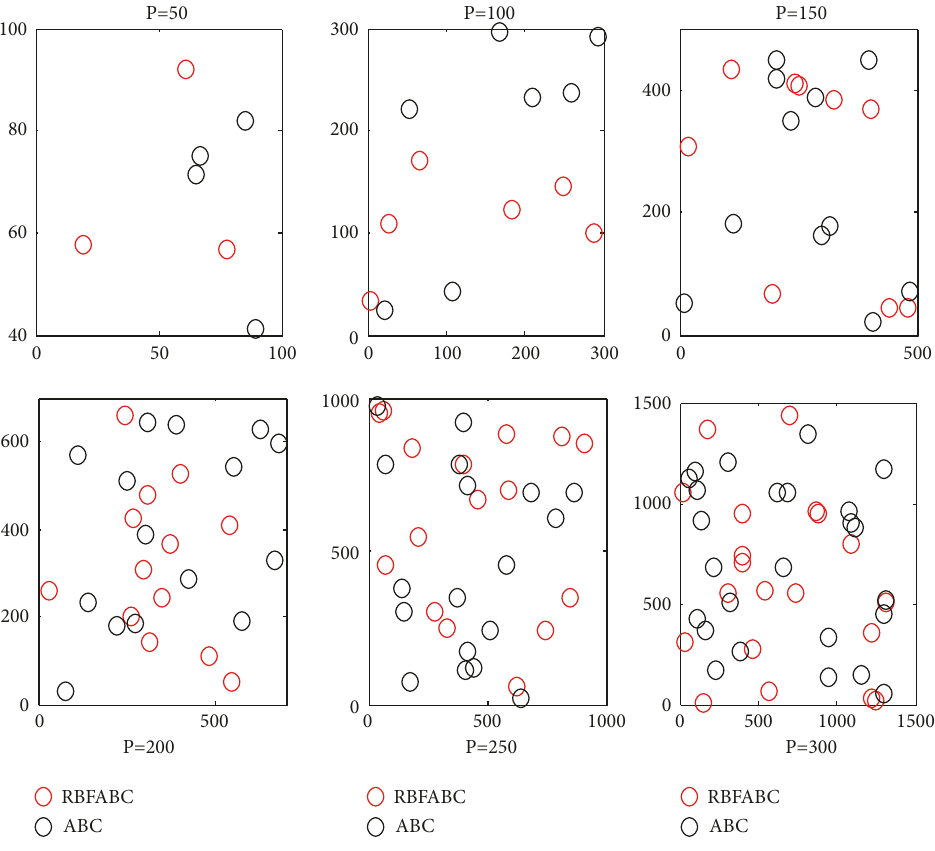
Figure 4: Node distribution under the same power.